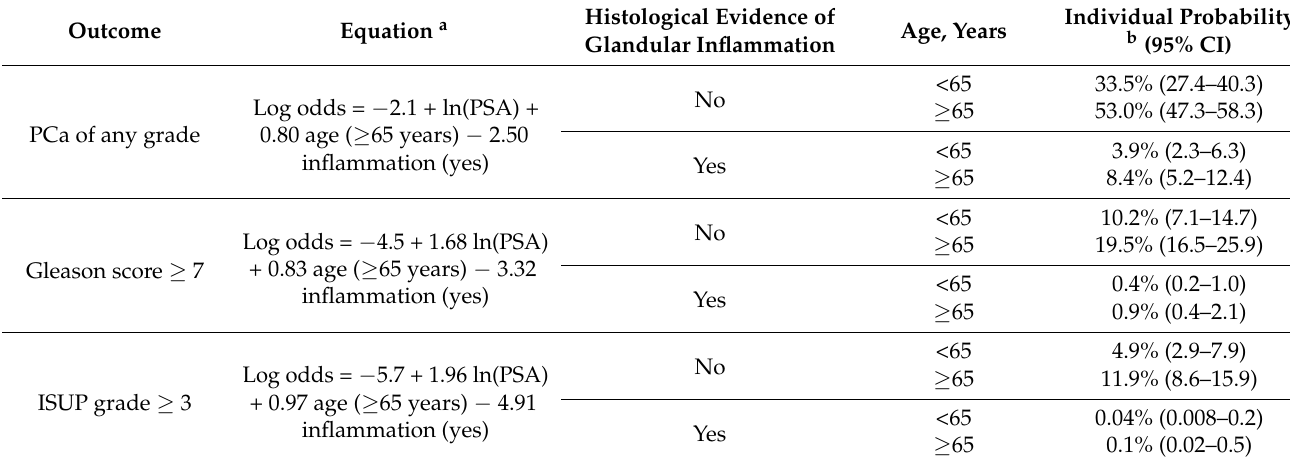
Table 2. Simulation of the probability of harboring a prostatic cancer (PCa) of any grade, advanced (Gleason score ≥ 7), and poorly differentiated grade (ISUP ≥ 3) for an individual with a baseline PSA value of 4.0 µ g/L. Outcome Equation a